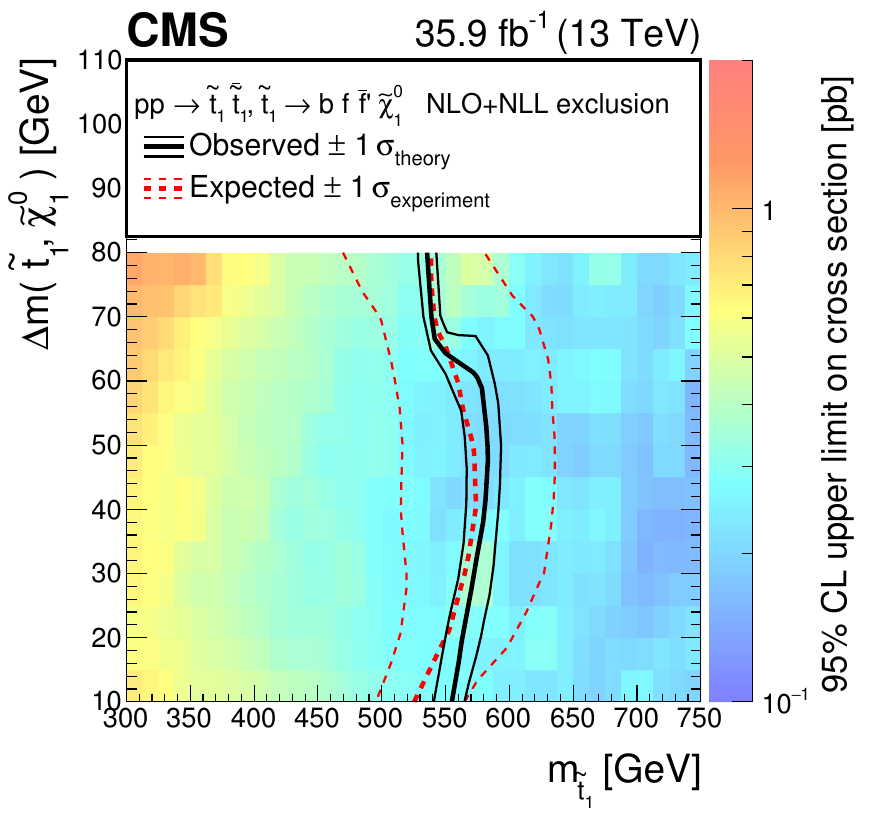
Figure 12 . Exclusion limits at 95% CL for top squark pair production followed by the four-body decay (cid:31) 0 and below the solid black curves represent the observed exclusion and the (cid:6) 1 standard deviation contours for the NLO+NLL cross section calculations and their uncertainties [65]. The dashed red curves represent the corresponding expectation at 95% CL and (cid:6) 1 standard deviation contours for the associated experimental